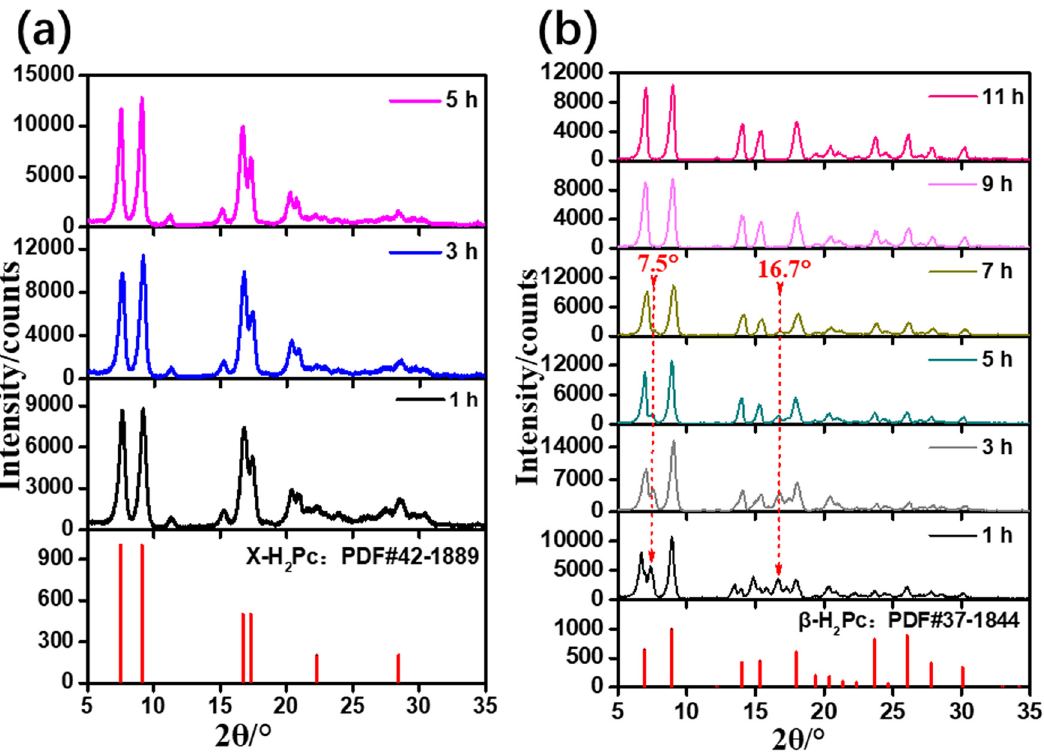
Figure 2: XRD patterns of the H 2 Pc obtained from di ff erent wet ball - milling time at 20°C ( a ) and 30°C ( b ) .